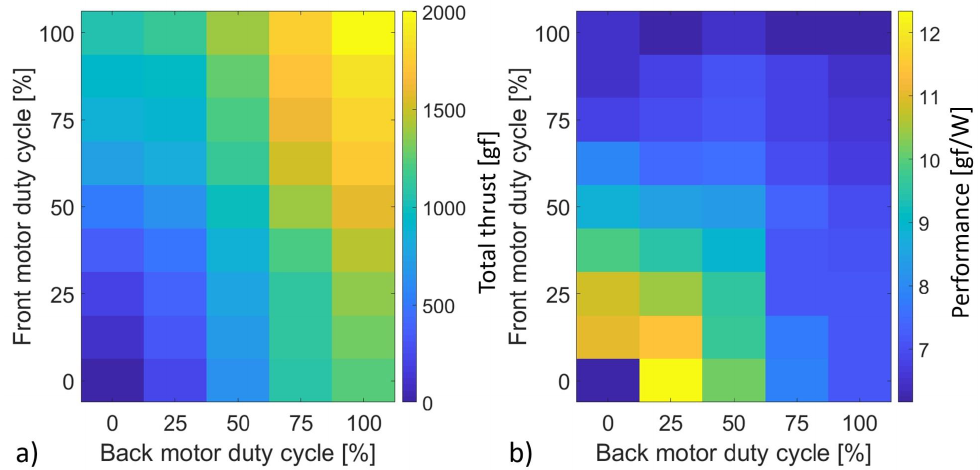
Figure 10. ( a ) System thrust output heat map and ( b ) System performance heat map for incremental front and back motor duty cycles.